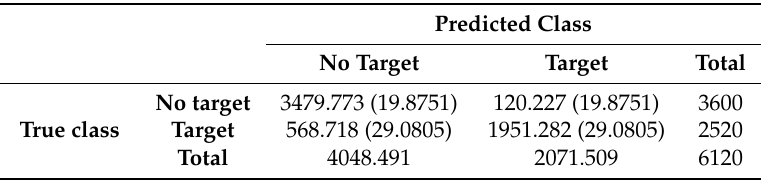
Table 4. Classification table of the model with the test data for 1000 simulations.The numbers in parentheses indicate the standard